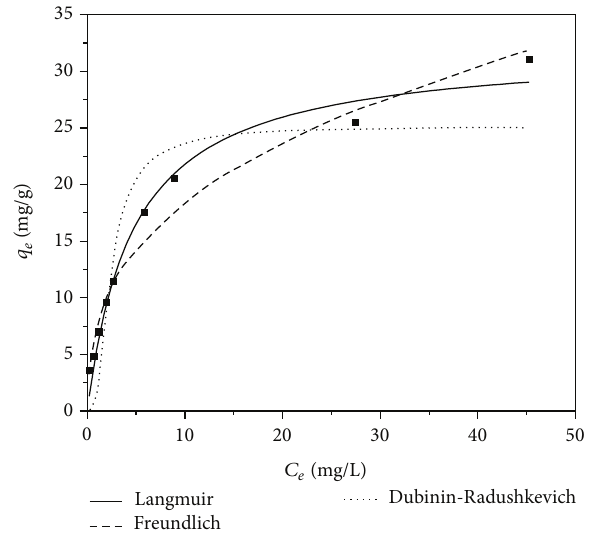
Figure 7: Biosorption isotherms of Cd(II) onto WAS.